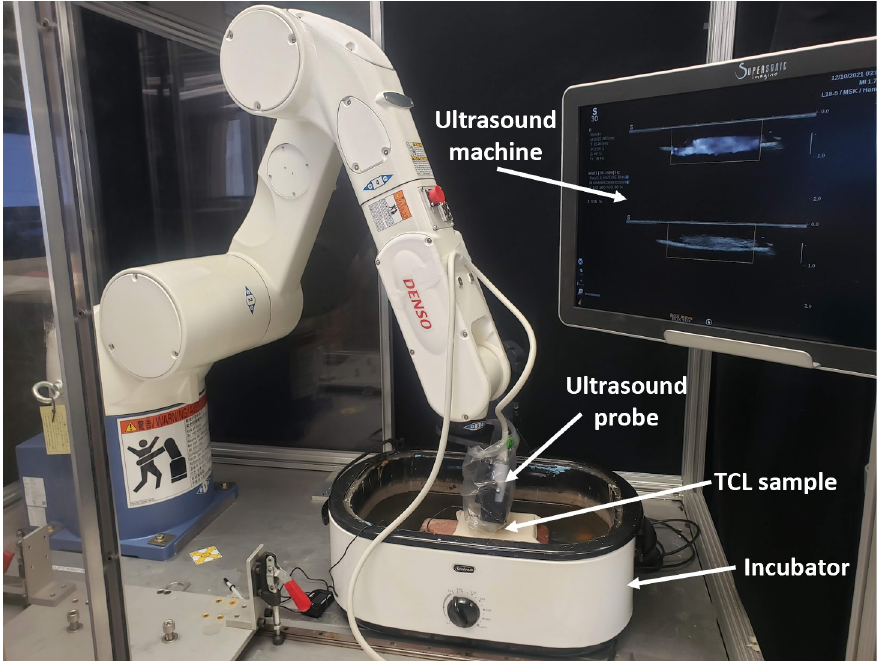
Fig 3. Experimental setup. Experimental setup for scanning